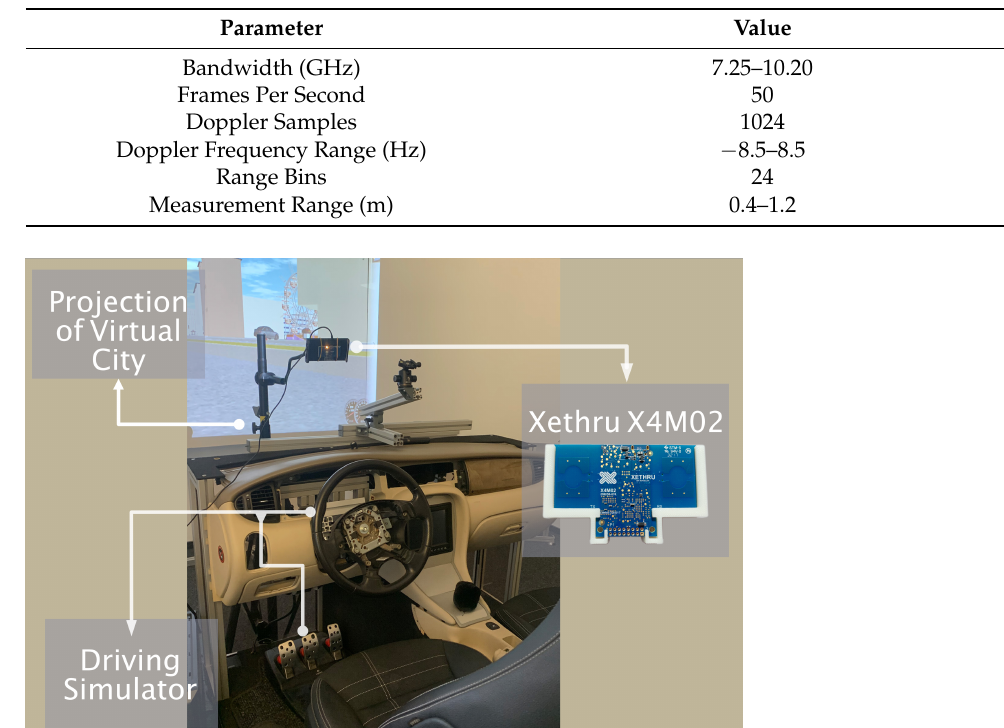
Table 1. Technical settings of Xethru X4M02 used for data recording.